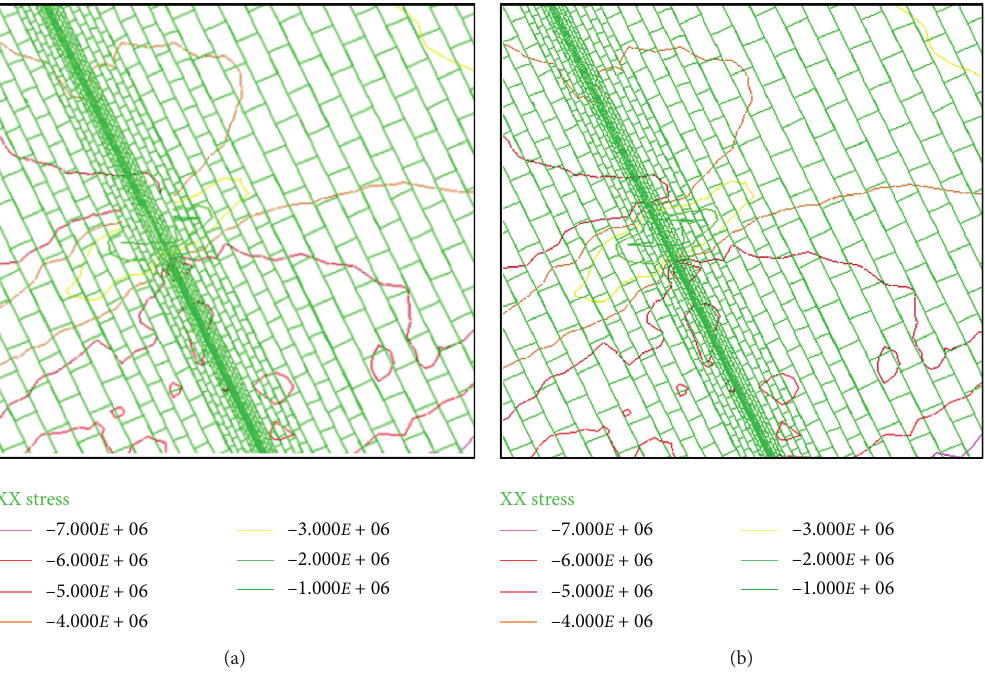
Figure 9: Surrounding rock horizontal stress distribution with 40m stope height. (a) Caving. (b) Backfilling.